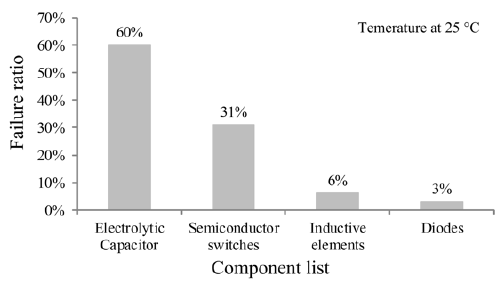
Figure 1. Distribution of failure of power components.